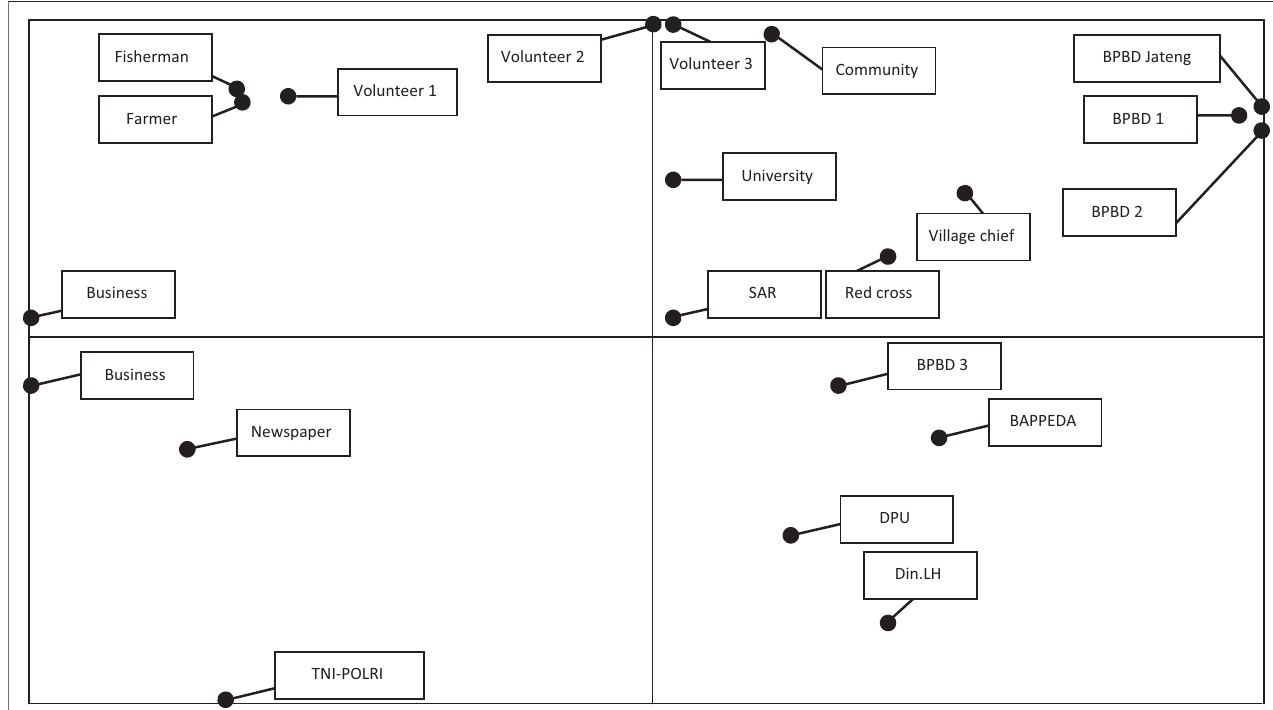
FIGURE 6: Convergent actor map in flood risk